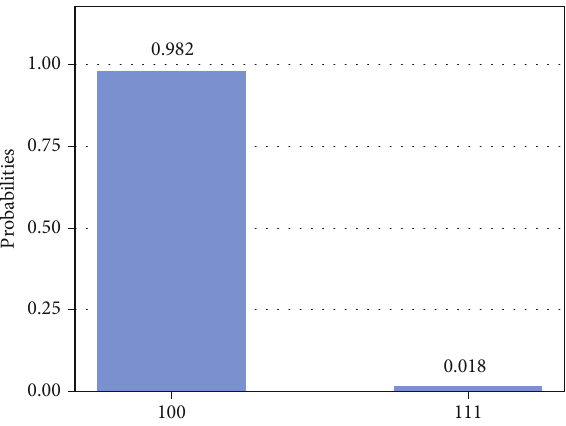
Figure 8: The simulation results for the circuit in Figure 7, where the measured qubits are q -LSB1 , q -LSB0 , and q check (bottom 0 0 to top) — there is a 0.018 probability of q check being in state j 1 i (also conditioned by the j 1 i state of the other two measured qubits). Here, q -LSB1 is always in state j 1 i , since the NEQR 0 representation of gray value 74 leaves the LSB qubit in state j 0 i Figure 10: The measurement result for the circuit in Figure 9. The with 100% probability, and adding a NOT gate inverts its state outcome for the vote value is always 10 (the result 01 can be (without modifying the probability). explained by taking into account the fact that in Qiskit, the measurement results are read bottom-top, in our case from the lower classical bit, cr_server , to the upper one, cr_voter